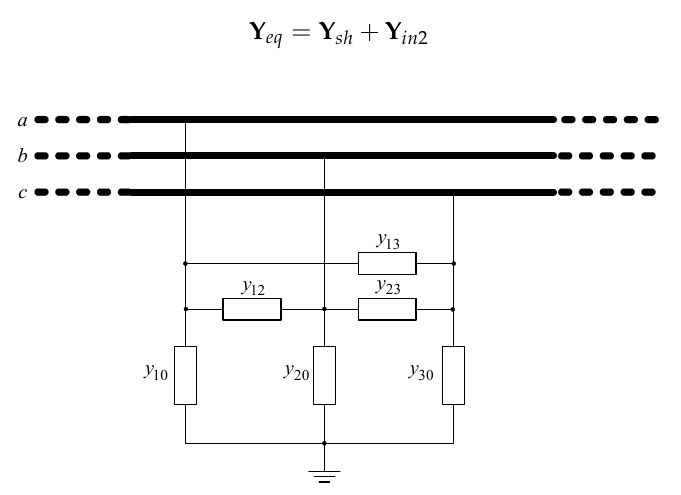
Figure 4. HV overhead power line fault modeled with shunt impedance.